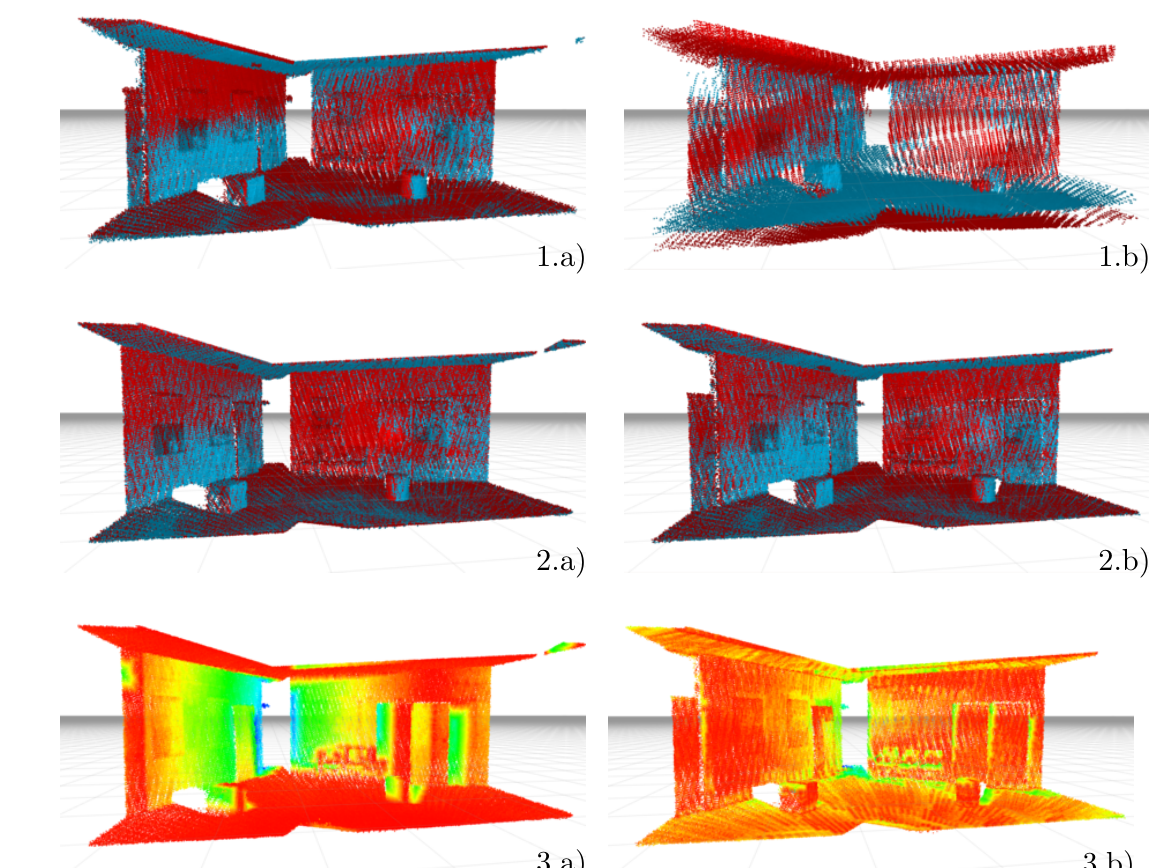
Figure 8. Point clouds sampling the excerpt of the test scene, the quality measure was applied to. The images ( 1.a , 1.b ) in the first row show the records done with the initial extrinsic parameter sets, used to study the influence of the initial pose the optimiser starts with. The cloud in ( 1.a ) results from using the sensor pose parameters measured on the SWAP platform by hand. The one in ( 1.b ) results from applying the transformation resulting from a deterioration of the measured transformation. Images ( 2.a , 2.b ) in the second row depict the resulting clouds after the parameter optimisation from the respective initial poses. The red and blue point colouring in the first two rows result from separating the two redundant measurements. The images ( 3.a , 3.b ) in the last row show the distances between the two clouds above. The intensity encodes the magnitude of changes with blue representing strong changes and reddish colors representing small